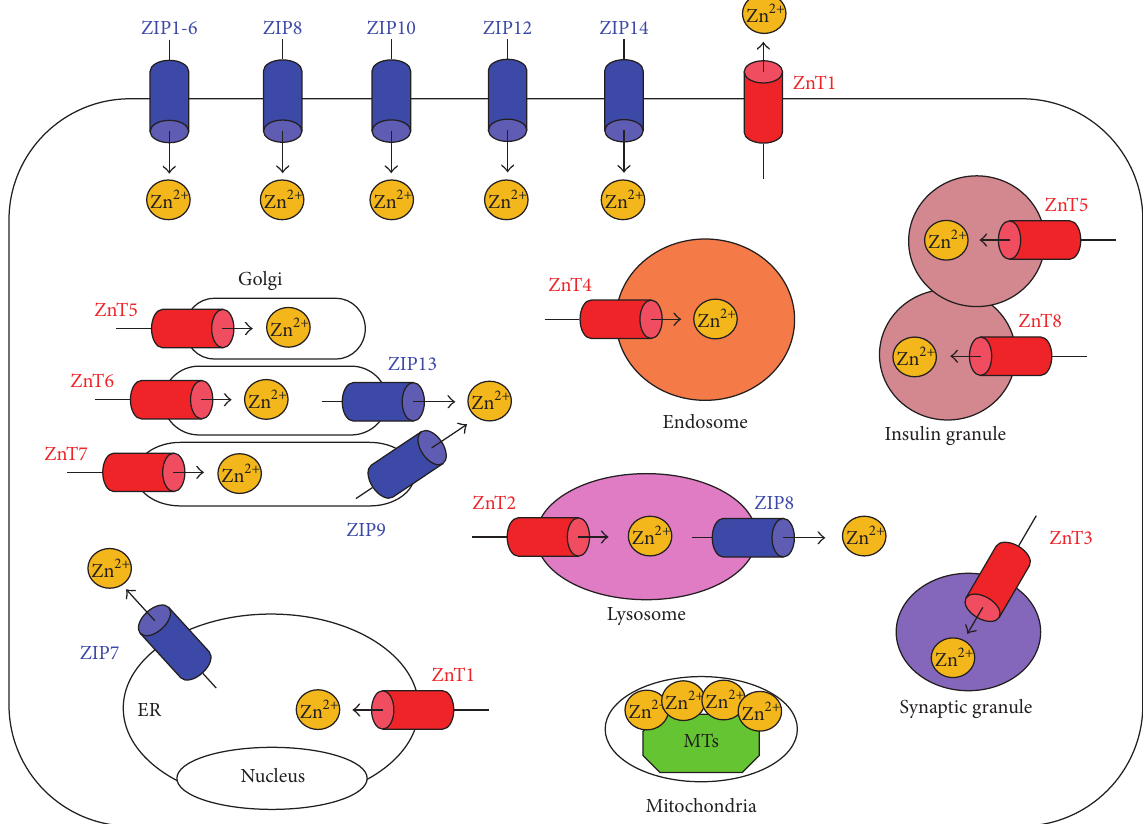
Figure 2: Subcellular localization of Zn transporters and metallothioneins (MTs). The localization of ZIP (blue) and ZnT (red) transporters is determined by the cell type, developmental process, and Zn status. ZIP transporters elevate the intracellular cytoplasmic Zn level by eliciting the influx of Zn from the extracellular space or from intracellular organelles. ZnT transporters reduce the intracellular cytoplasmic Zn level by exporting Zn from the cytosol to the extracellular space or into intracellular organelles or vesicles. MTs (green) contribute to Zn storage. Arrows indicate the predicted direction of Zn mobilization. ER: endoplasmic